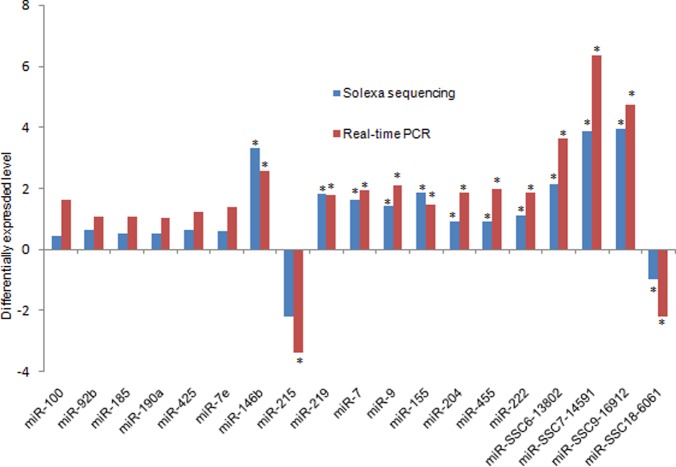
Validation of sequencing results by real-time quantitative PCR.Four biological replicates were used, and U6 snRNA was used as an internal control. The y-axis is the fold-change between W4 and S4 samples (fold quantity values for real-time PCR; Log (W4/S4, 2) for Solexa sequencing). Means with the star on the column differ significantly (P<0.05). W4, the samples from piglets on days 4 after weaning. S4, the samples from suckling piglets on the same days on which W4 samples were collected.